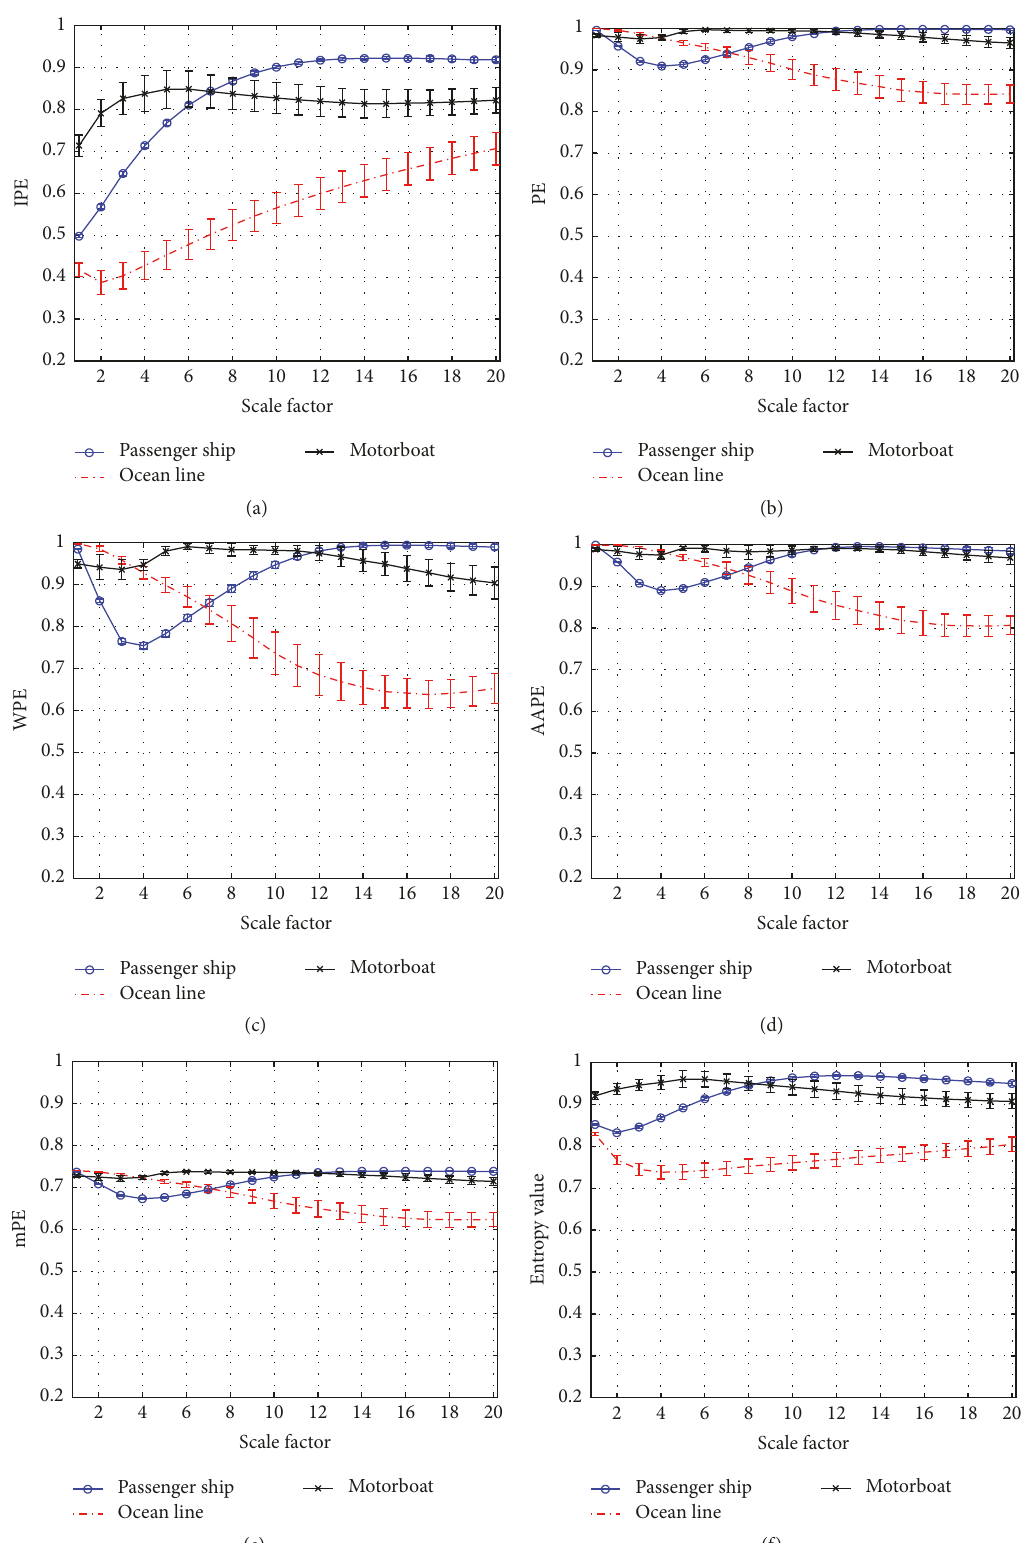
Figure 10: Entropy analysis of three types of ship-radiated noise in 5dB condition. (a) Result of IPE. (b) Result of PE. (c) Result of WPE. (d) Result of AAPE. (e) Result of mPE. (f) Result of